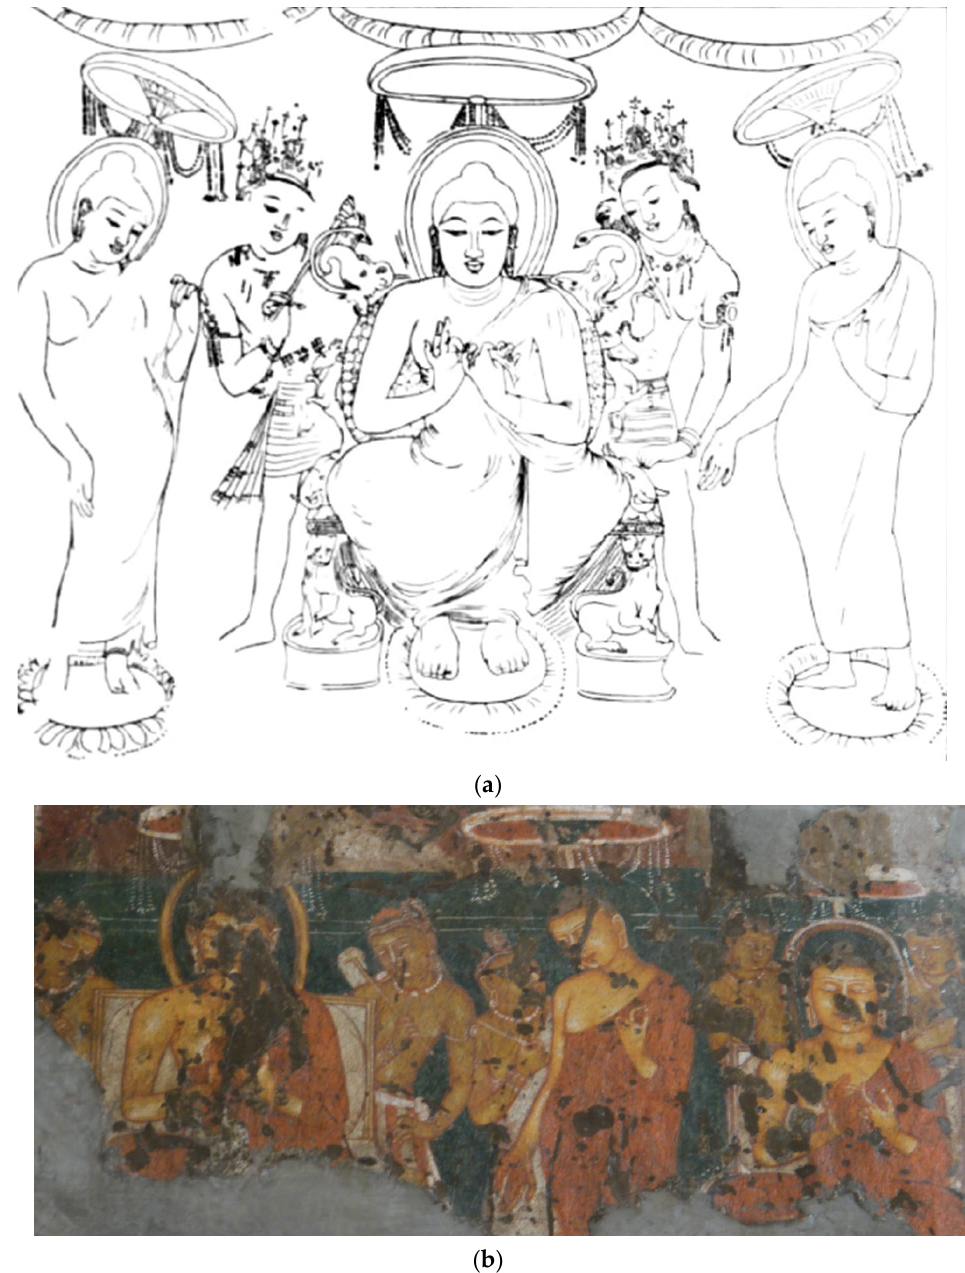
Figure 2. Intrusive mural painting from the triforium of Aja ṇṭ ā Cave 9, ca. 478–480 CE (( a ) Line drawing after Foucher 1917, pl. XXI, 1; ( b ) Photograph by the author).